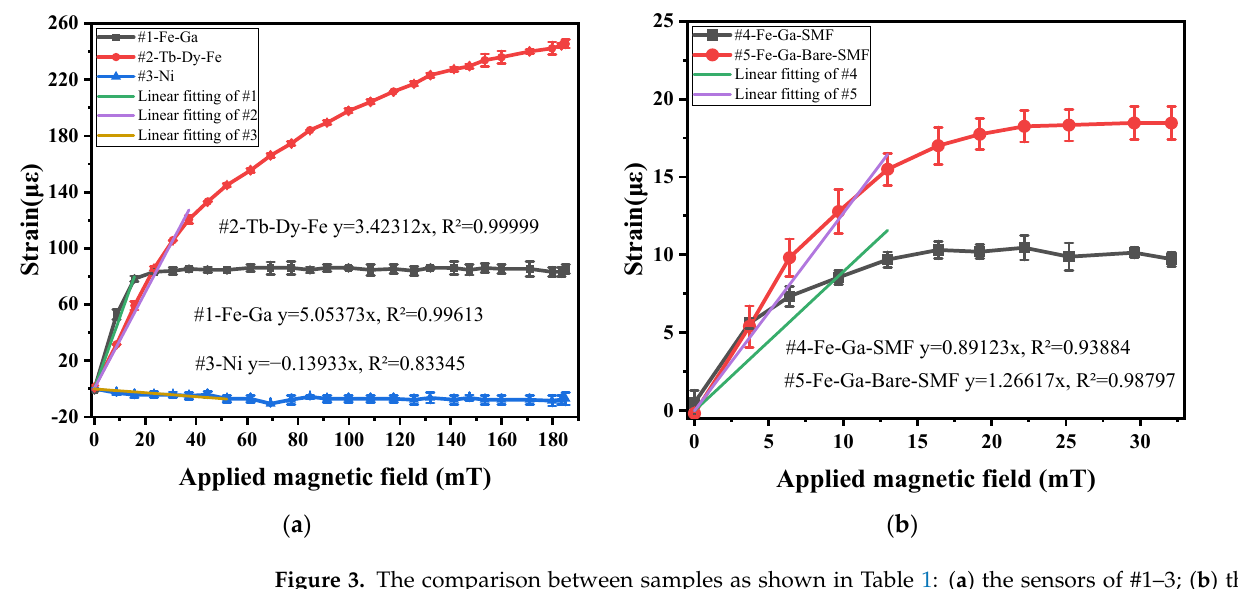
Figure 3. The comparison between samples as shown in Table 1: ( a ) the sensors of #1–3; ( b ) the sensors of #4 and #5. Table 2. Sensitivity of the sample.